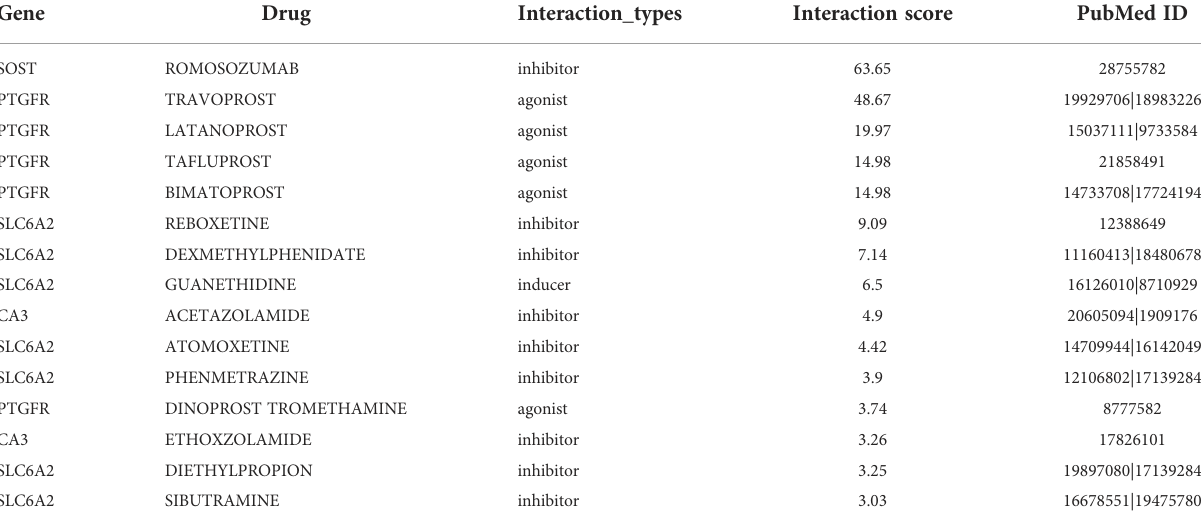
TABLE 2 Information of the top 15 drugs fi ltered by Interaction